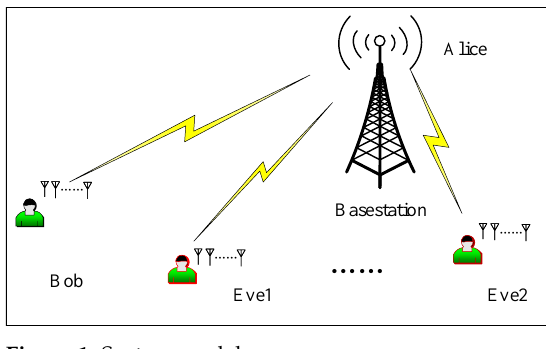
Figure 1. System